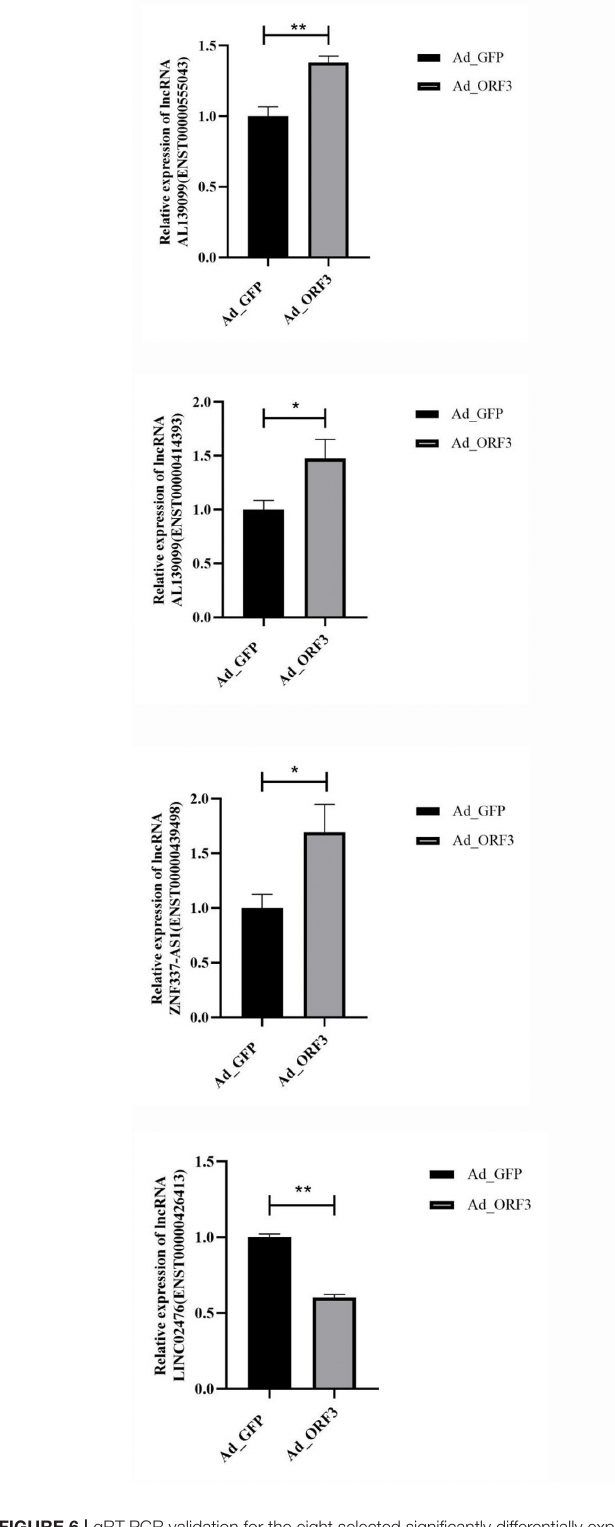
Frontiers in Veterinary Science |